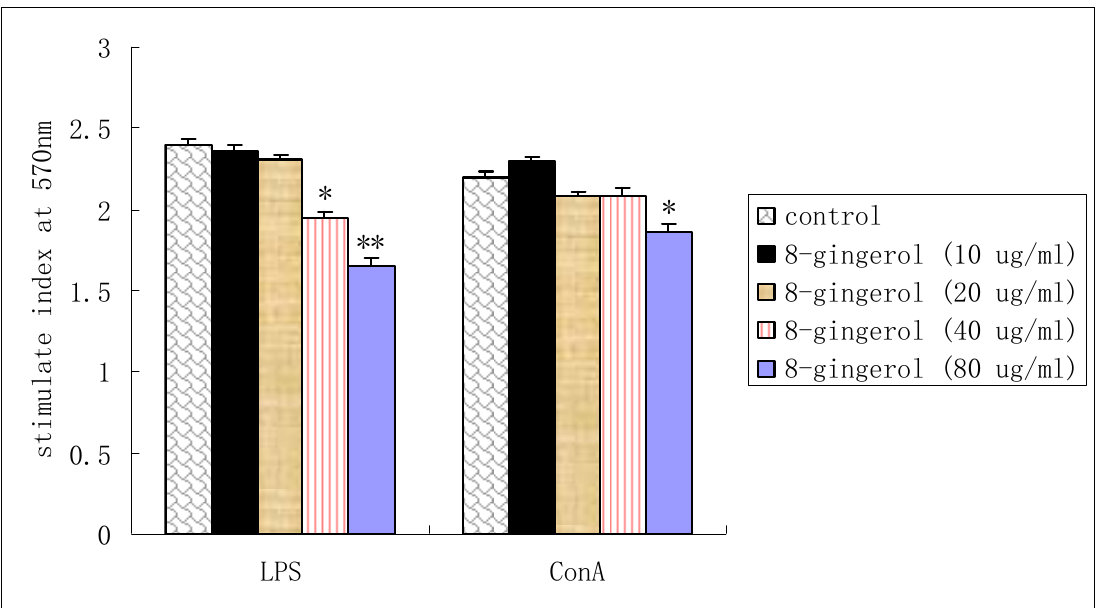
Figure 3. Effect of 8-gingerol on splenocyte proliferation in vitro